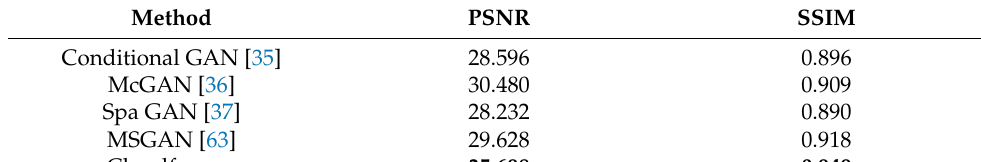
Table 4. Quantitative evaluation on RICE2.